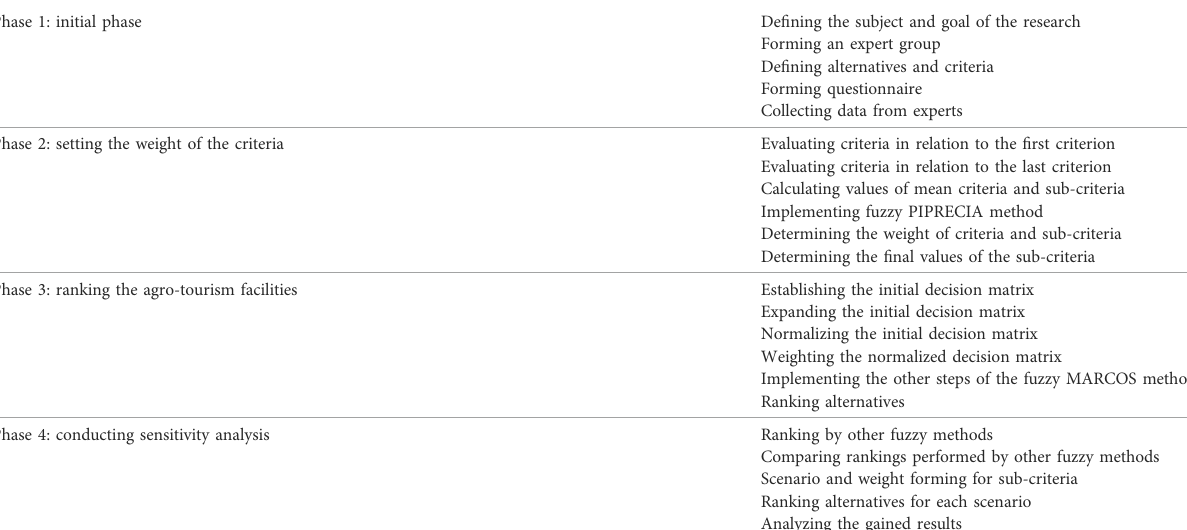
TABLE 1 Methodological